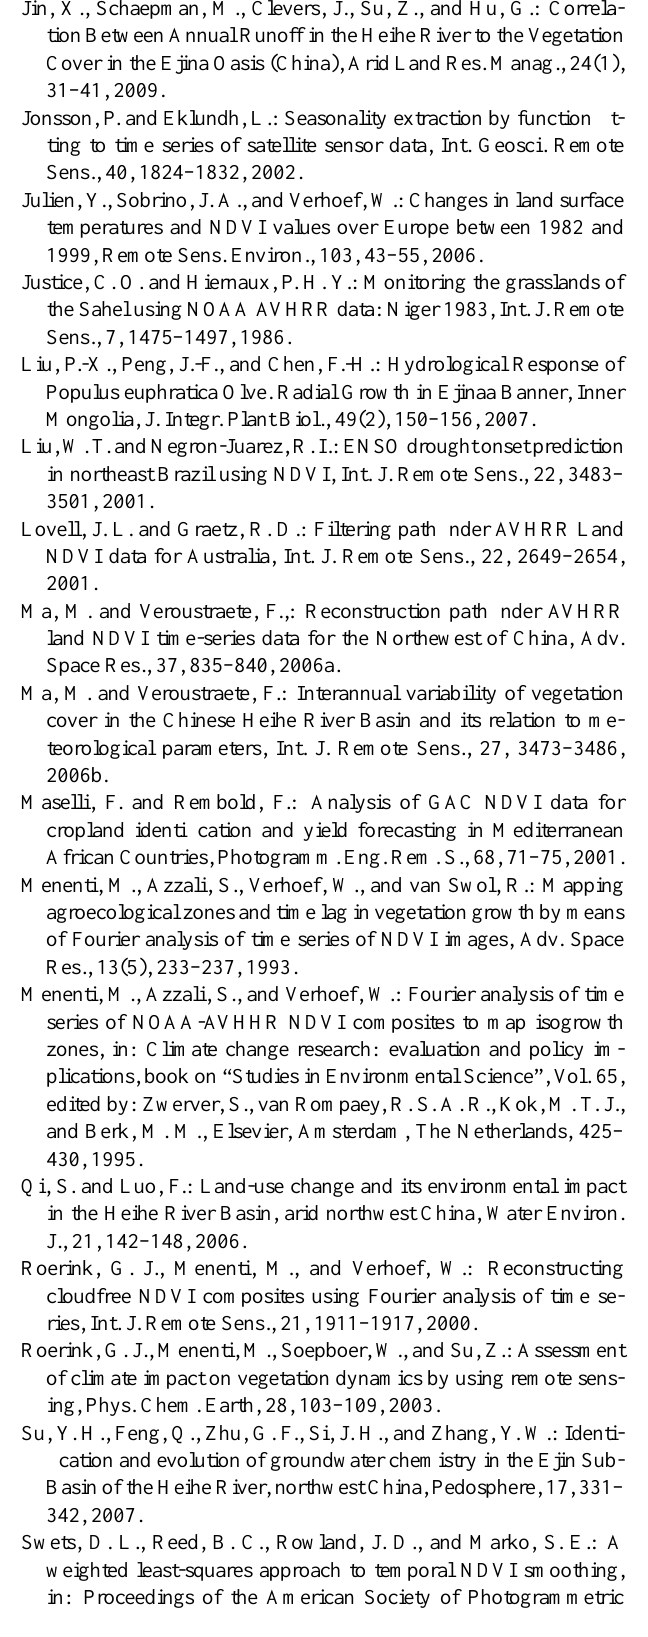
groundwater table depth and the S-N gradient in the timing of peak green up should be verified by field experiments de- signed to verify this hypothesis.